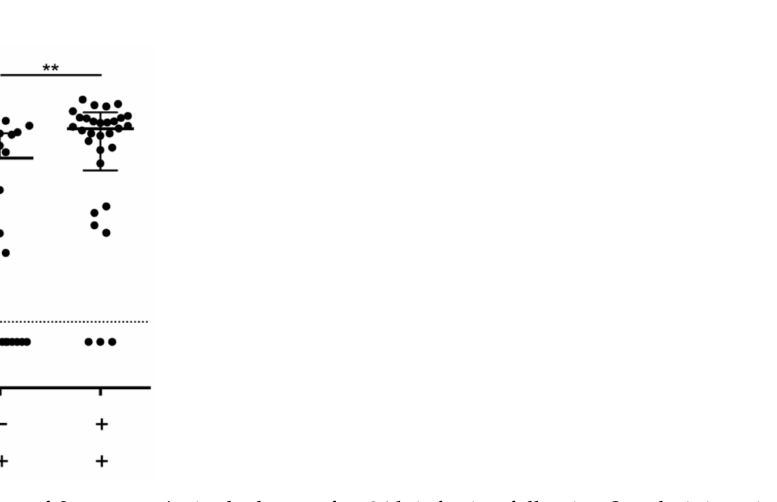
Figure 3. The number of S. pneumoniae in the lungs after 24 h infection following Sp administration and Sp and PgSup administration. “+” indicates the presence of PgSup or Sp, and “ − ” indicates the absence of PgSup or Sp. Each point in the graph represents an individual mouse. Samples below the detection limit (>8000 CFU/g) were standardized to 4000 CFU/g. Two groups were analyzed by an unpaired t-test, and data are presented as the mean ± SD (** p < 0.01).